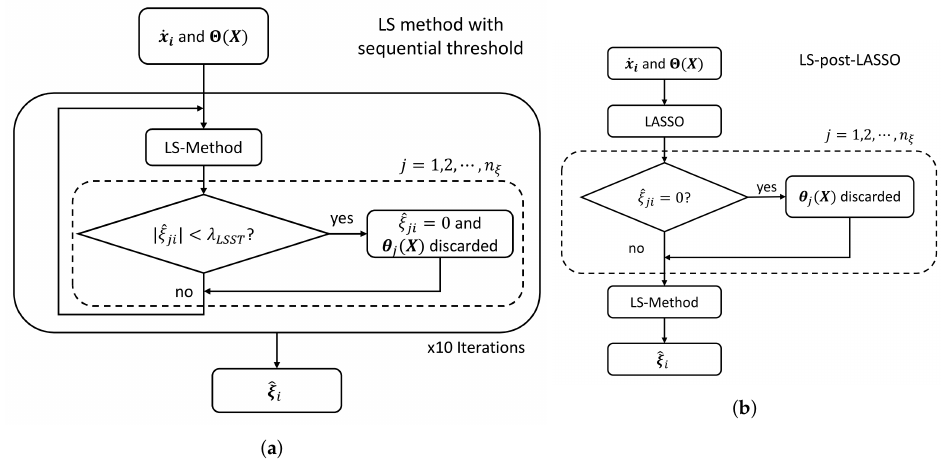
Figure 1. Flowchart of ( a ) LSST and ( b )